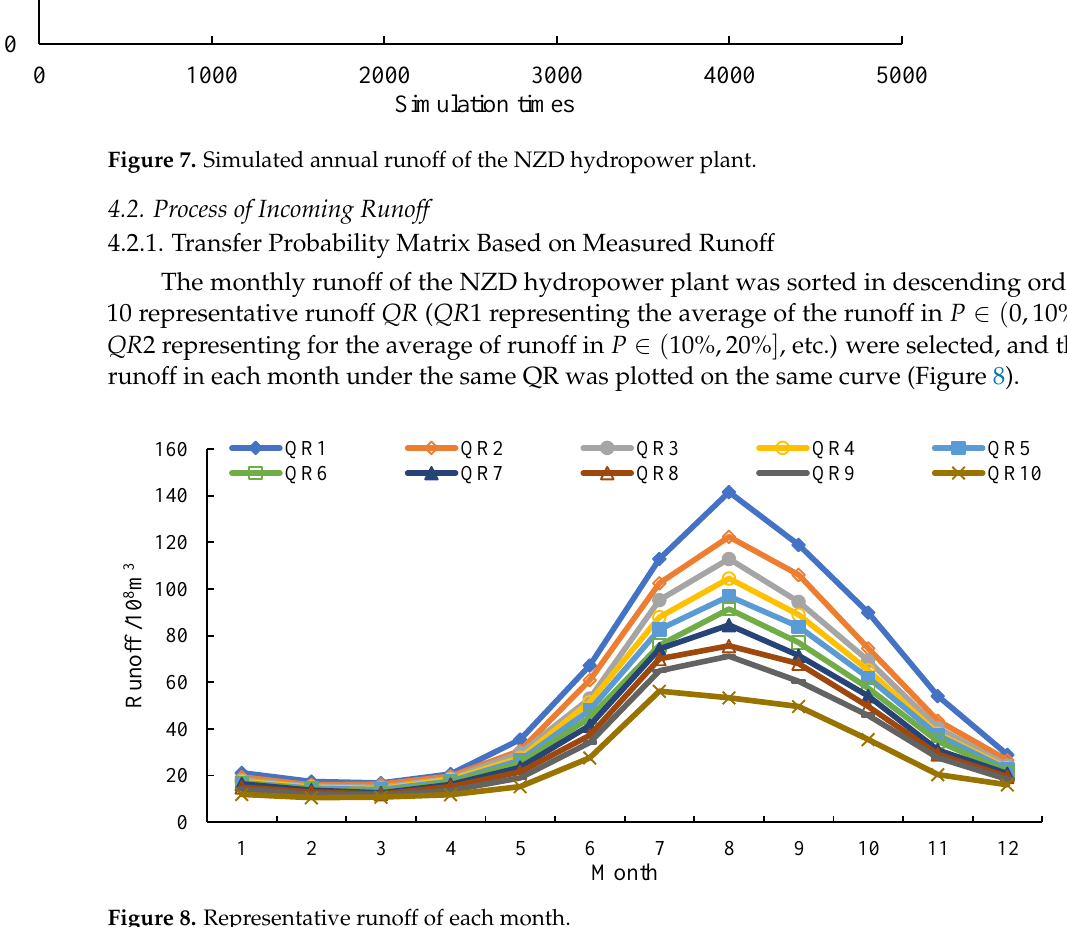
Figure 8. Representative runoff of each month.